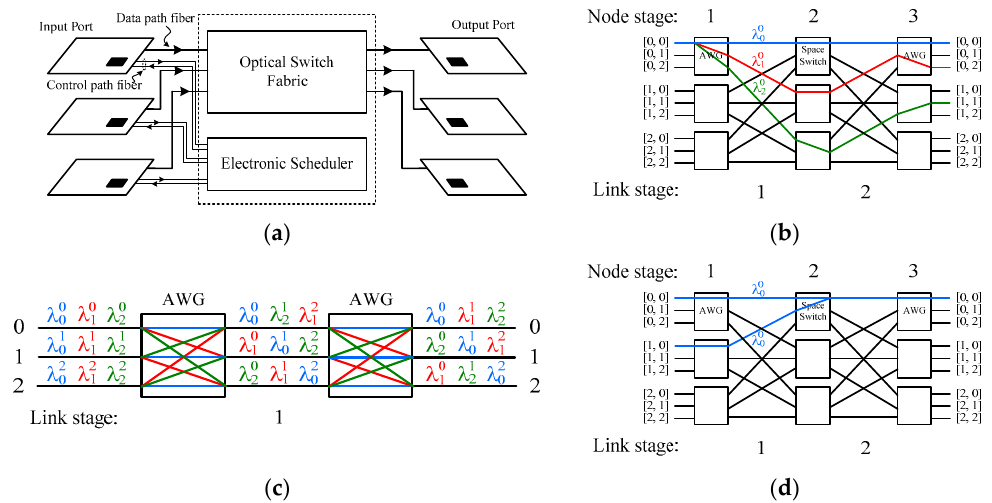
Figure 2. ( a ) The optical data path and the electronic control path of a 3-stage ASA switch. ( b ) The data plane of a 3-stage 9 × 9 ASA (AWG, Space switching, AWG) switch. ( c ) A 2-stage switch cascading two 3 × 3 AWGs. ( d ) Two signals ([0, 0], 0, [0, 0]) and ([1, 0], 0, [0, 0]) collide at the same link in stage 2.